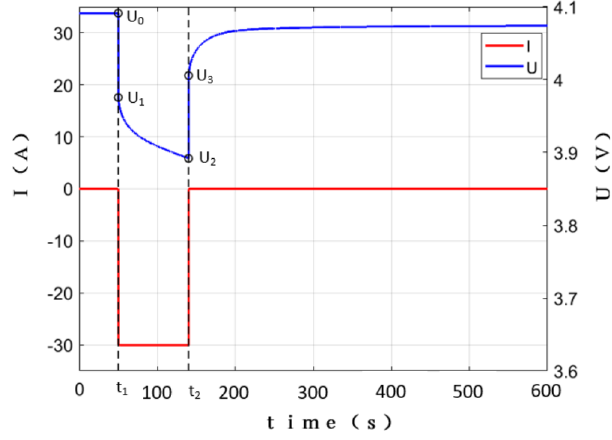
Figure 4. The curve of the current and voltage parameter while SOC =